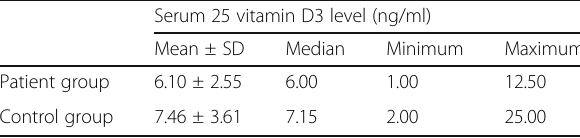
Table 2 Serum 25 vitamin D3 in patients and control groups